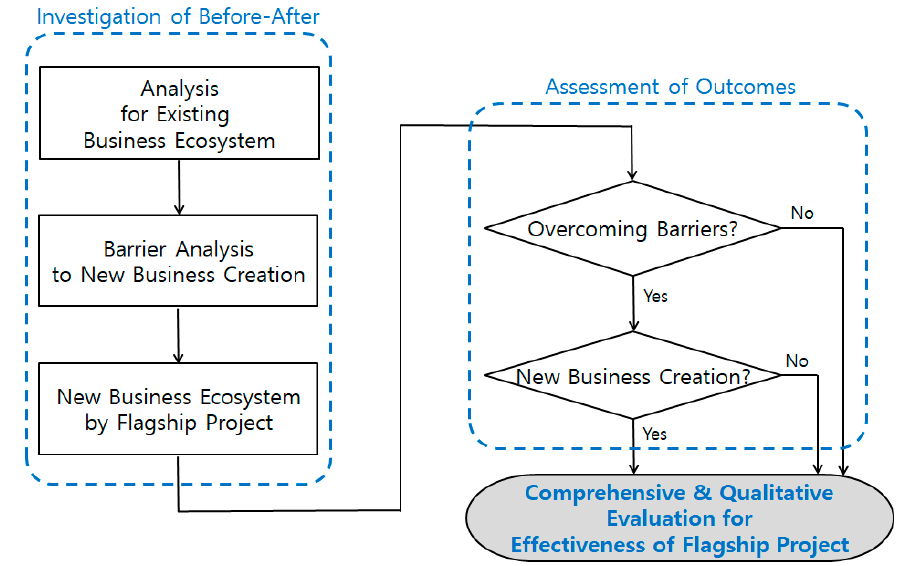
Figure 3. Analysis framework based on the logic model method.